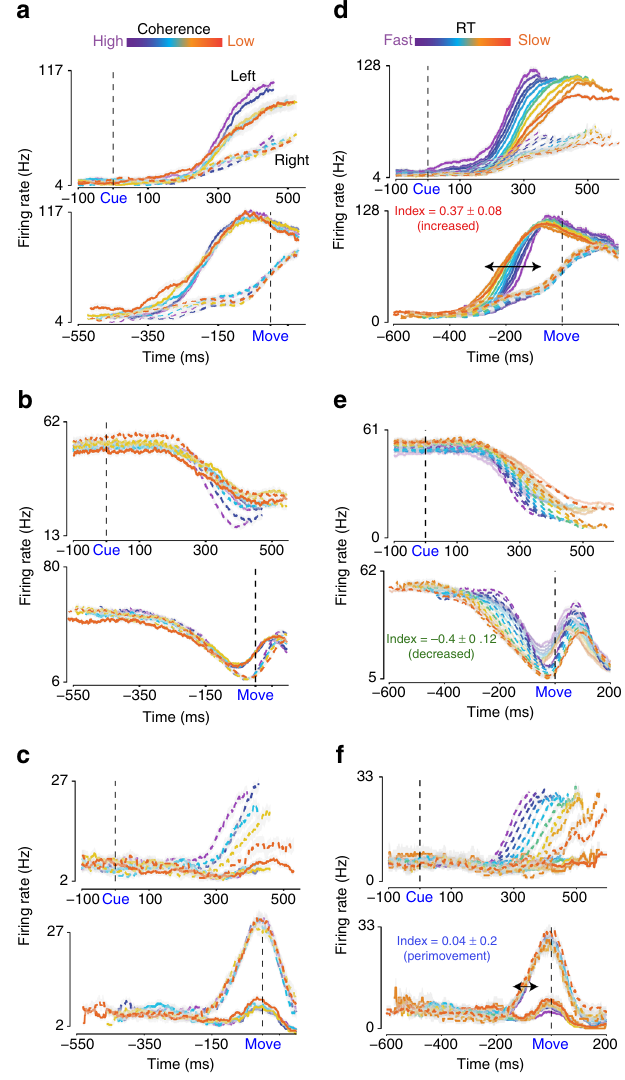
Fig. 2 FRs in PMd demonstrate an organized relationship to different elements of the decision-making process. a – c Three example units in PMd during the decision task sorted by color coherence and arm movement choice when aligned to checkerboard cue onset (labeled as “ cue ” , top panel ) or movement onset ( bottom panel ). Solid lines of different colors ( — ) depict left reaches; dashed lines of varying colors (---) depict right reaches. The colors ranging from purple to orange depict color coherence (high to low). The black dashed lines depict the onset of the checkerboard cue ( top panels ) or the onset of the arm movement ( bottom panels ). When aligned to checkerboard cue onset, FR is plotted until the median RT for the color coherence. When aligned to movement onset, the FR is plotted until the negative of the median RT for the color coherence. Error bars denote standard error of the mean (SEM) over trials. We estimated peristimulus and perimovement FRs by convolving spike trains with 75 ms causal boxcars. Averages include all trials sorted according to the choice of the monkey (left vs. right). Unit a: 782 trials, Unit b: 1454 trials, Unit c: 655 trials. Individual traces are averages of at least 30 trials. d – f FRs of the units that are shown in a – c when sorted by RT. The colors ranging from purple to orange depict RT bins (fast to slow, all color coherences combined). Line conventions for left and right reach directions are as in a – c . FR traces, when aligned to checkerboard cue onset and organized by RT, are shown until the center point of the RT bin. The visuomotor index (see Fig. 3a, and corresponding text), along with the label is shown for each unit along with CI for the index. The index is signi fi cantly different from 0 for units in a , b (CIs do not overlap with 0) but not c (CIs overlap with 0). The trials used in d – f are same as those used for the plots in a – c except re-sorted according to the various RT bins. In Fig. 2e, FR traces for the left reaches are deliberately reduced in opacity to better highlight the structure in the FR traces for right reaches and their organization with RT. FRs for left reaches also have the same structure. Additional examples of unit responses